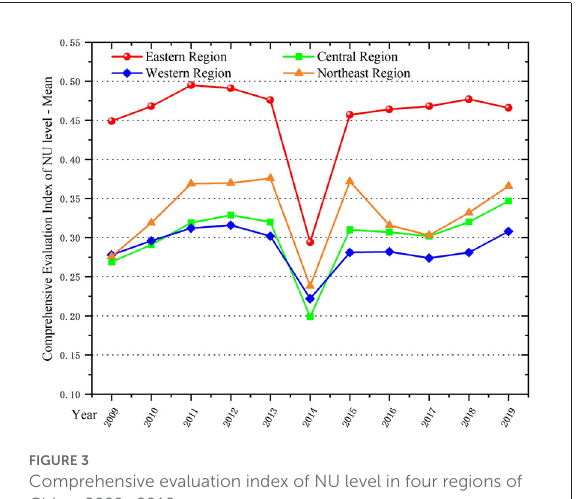
FIGURE2 Comprehensive evaluation index of TI capability in four regions of China, 2009–2019.